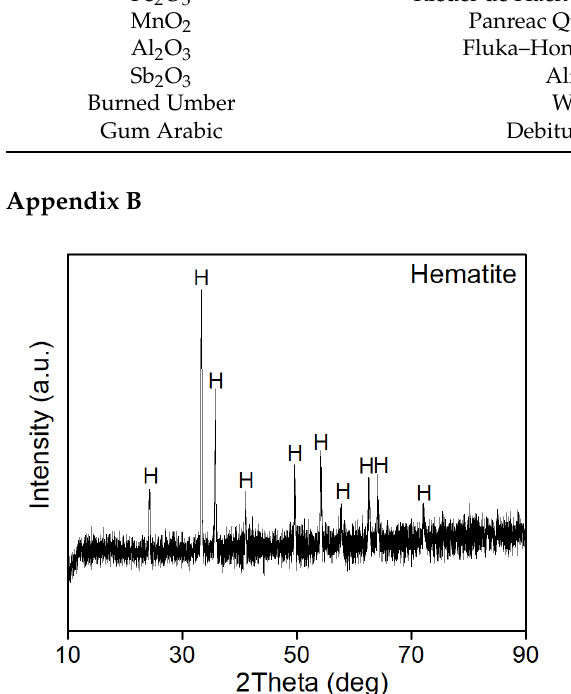
Figure A1. XRD result for burned iron. Hematite (H) was identified.